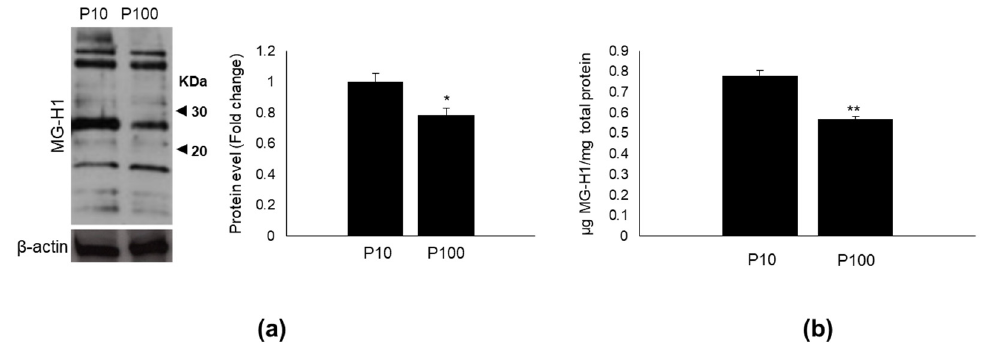
Figure 3. HASC-P10 and HASC-P100 EVs contain MG-H1. ( a ) Representative Western blot (WB) of MG-H1 and quantitative histogram of the relative MG-H1 protein expression levels. β -actin was used as internal loading control for WB normalization. The WB bands of MG-H1 were quantified by densitometric analysis (sum of multi-bands intensity), normalized against β -actin, and expressed as relative protein level (fold change). ( b ) Levels of MG-H1, measured by a specific ELISA kit. The histograms indicate the mean ± SD of two independent experiments. * p < 0.05 and ** p < 0.01 vs. P10.